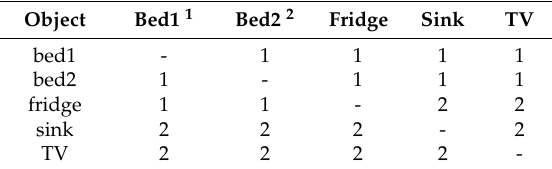
Figure 8. Experimental environments. ( a ) Room environment, ( b ) o ffi ce environment, ( c ) object semantic grid and topological map of home, ( d ) object semantic grid and topological map of o ffi ce, ( e ) door endpoints of home, and ( f ) door endpoints of o ffi ce. Table 1. Navigation goal in home.